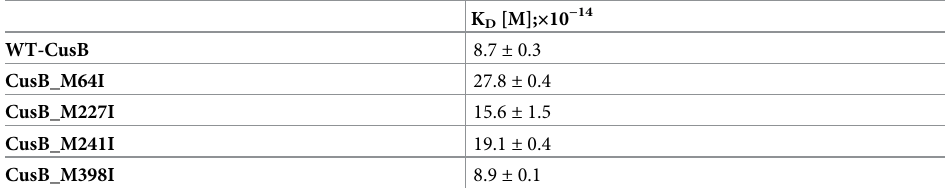
Table 1. Calculated K D values for CusB